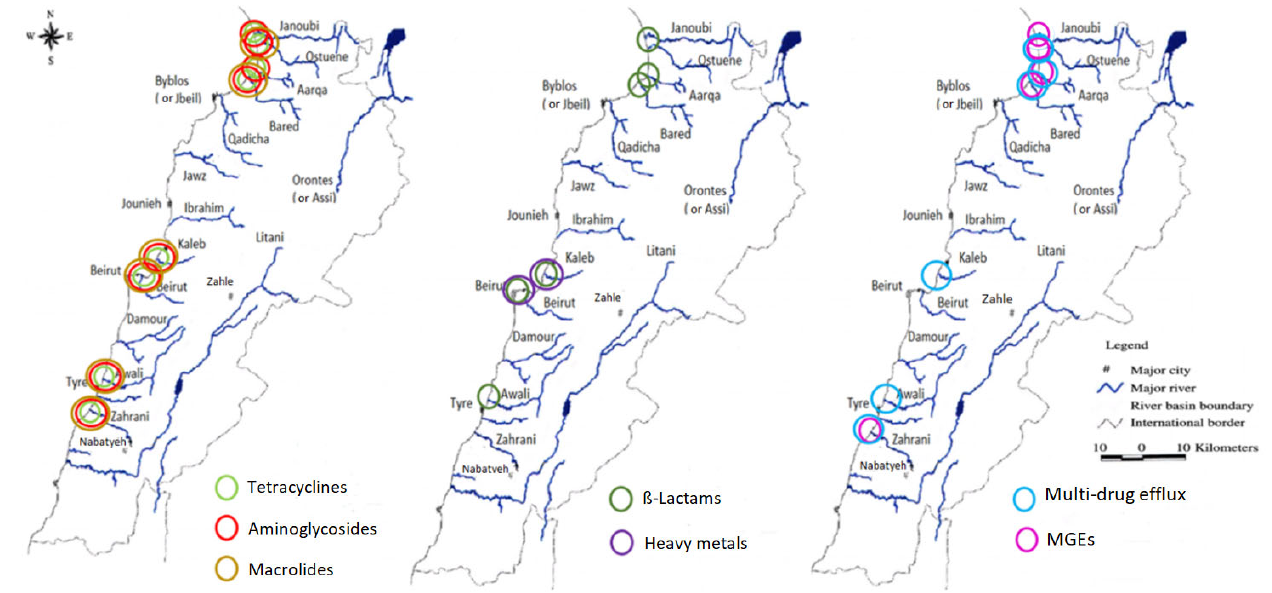
Figure 3. Graphical representation showing the estuaries where an increase in the mean normalized abundances of the ARGs families and MGEs (transposase genes, integron integrase genes, and the IncP-1 gene were grouped together as mobile genetic elements) from spring (2017) to winter (2018) was significant ( p < 0.05).